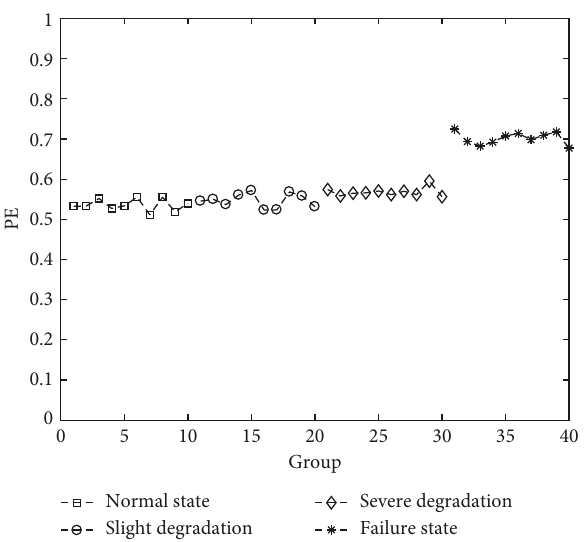
Figure 9: The normalized PE results of the original